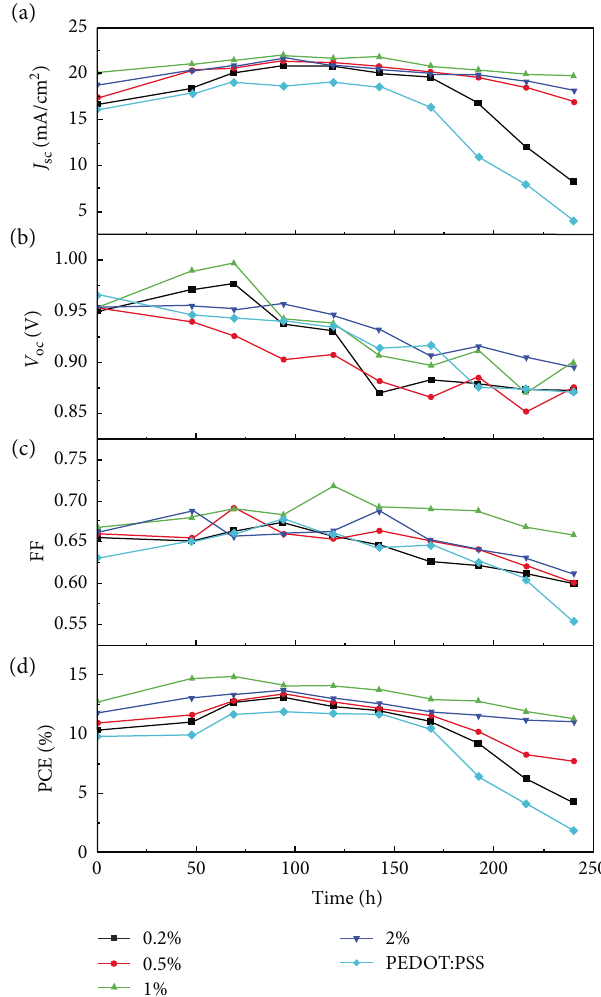
Figure 9: (a) J , (b) V , (c) FF, and (d) PCE values as a function of aging time of the devices with di ff erent MoO sc oc pristine PEDOT:PSS HTLs. Reprinted with permission from